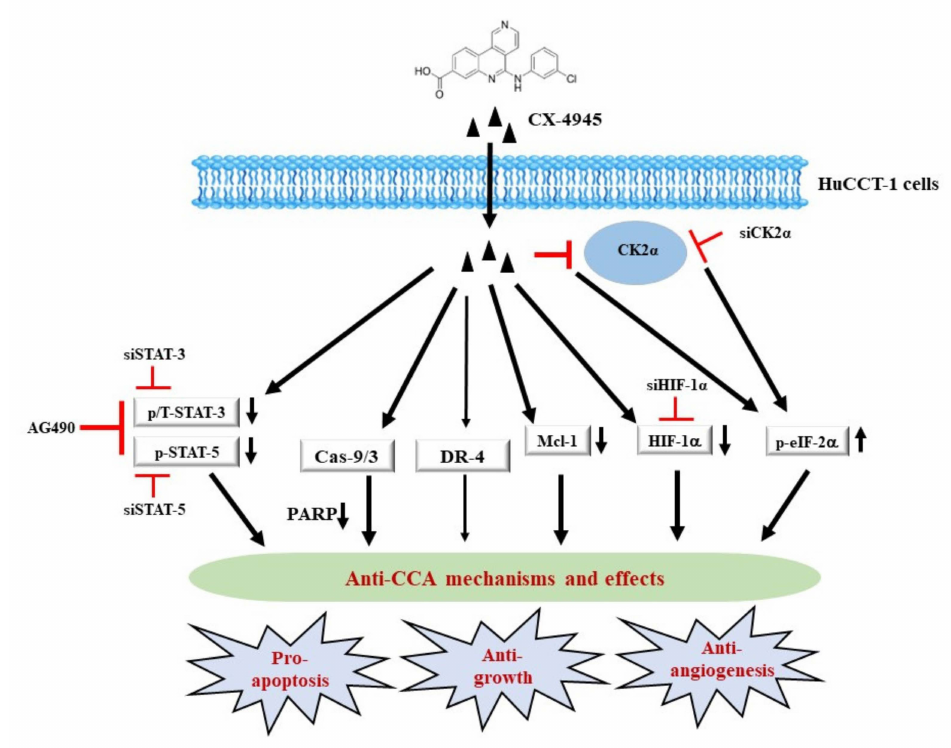
Figure 9. A diagram of the CX-4945’s anti-cancer mechanisms in HuCCT-1 CCA cells. CX-4945 may directly inhibit its target CK2 and downstream effector pathways. CX-4945 may further indirectly regulate additional targets, including the intrinsic (caspase-9/3) and extrinsic (DR-4) pathways, STAT-3/5, Mcl-1, and HIF-1 α . Moreover, CX-4945 may induce eIF-2 α -dependent global translational inhibition. These alterations will contribute to the drug’s anti-survival, pro-apoptotic, and anti- angiogenic effects on HuCCT-1